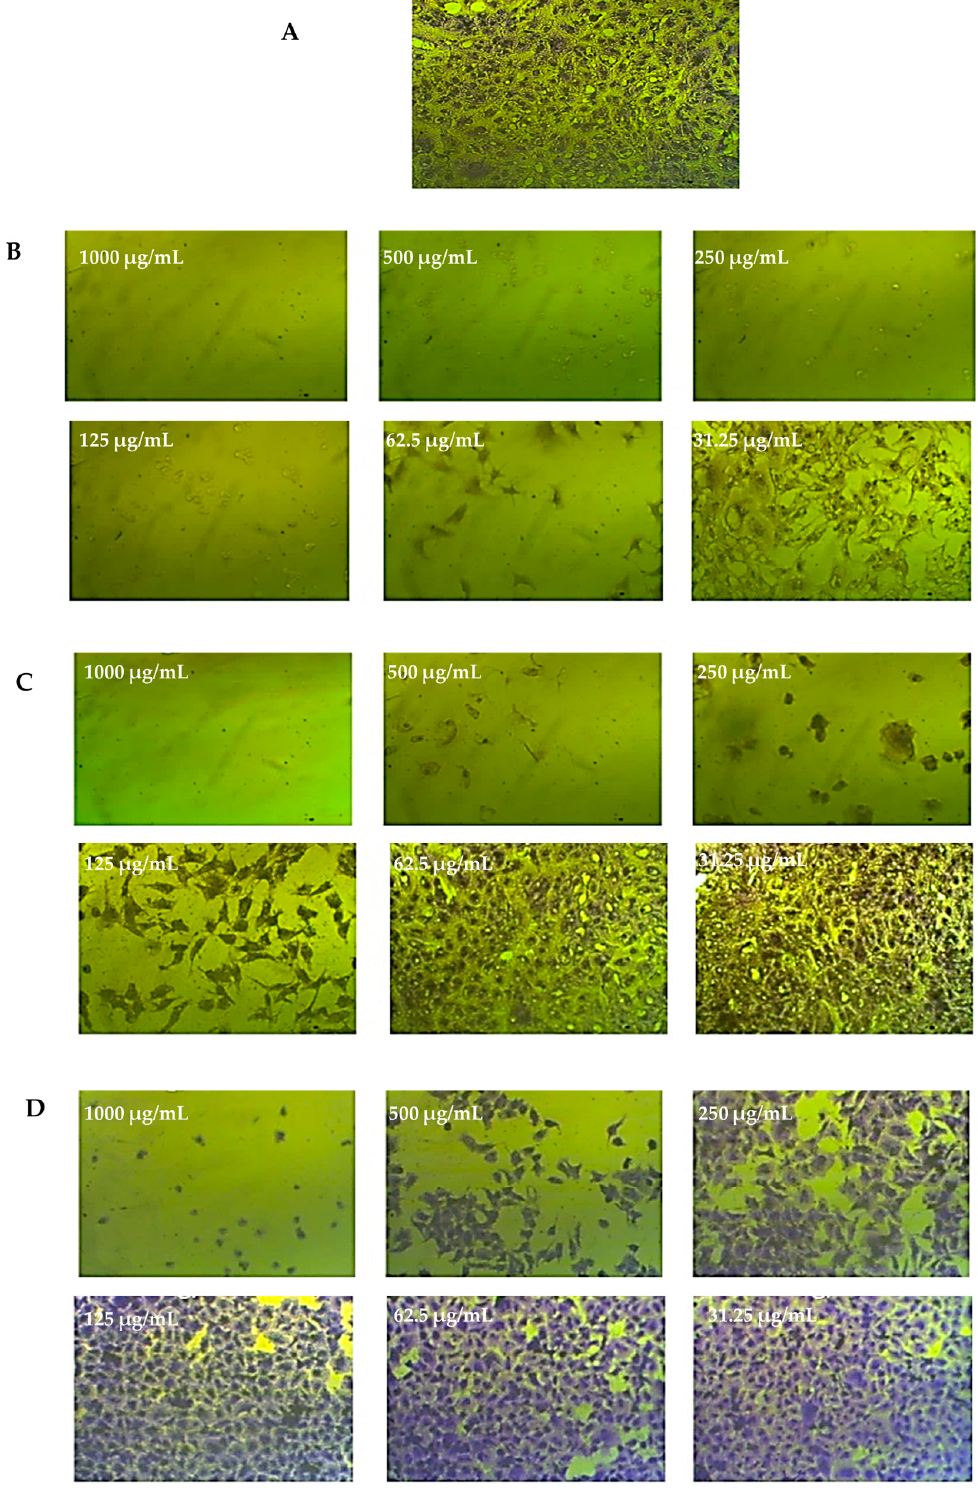
Figure 6. An example of the moderate anticancer effect of the stems extract from Calystegia sylvatica against cervical cancer cell lines (HeLa): ( A ) complete monolayer sheets of cervical cancer cells (HeLa) that have not been treated; ( B ) the effect of doxorubicin treatment at different concentrations; ( C ) the effect of the stems extract from C. sylvatica against HeLa cell lines at different concentrations; ( D ) the effect of the stems extract from C. sylvatica against normal human fetal lung fibroblast (WI38).